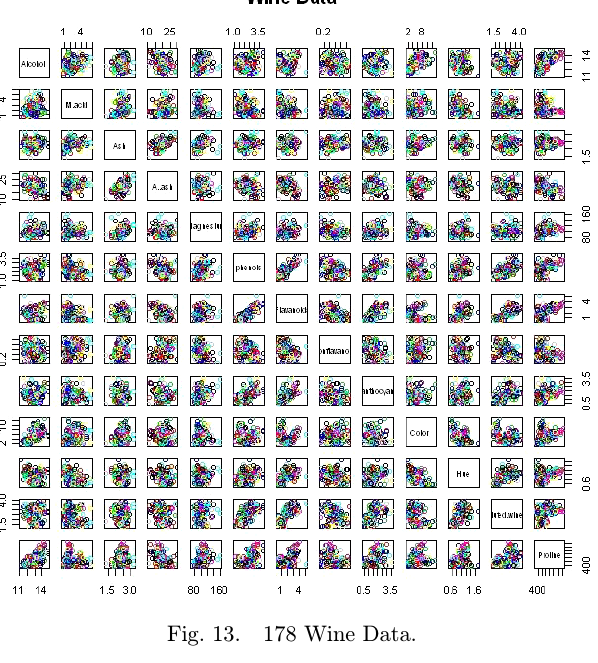
Fig. 15. 1000 Check board Dataset.